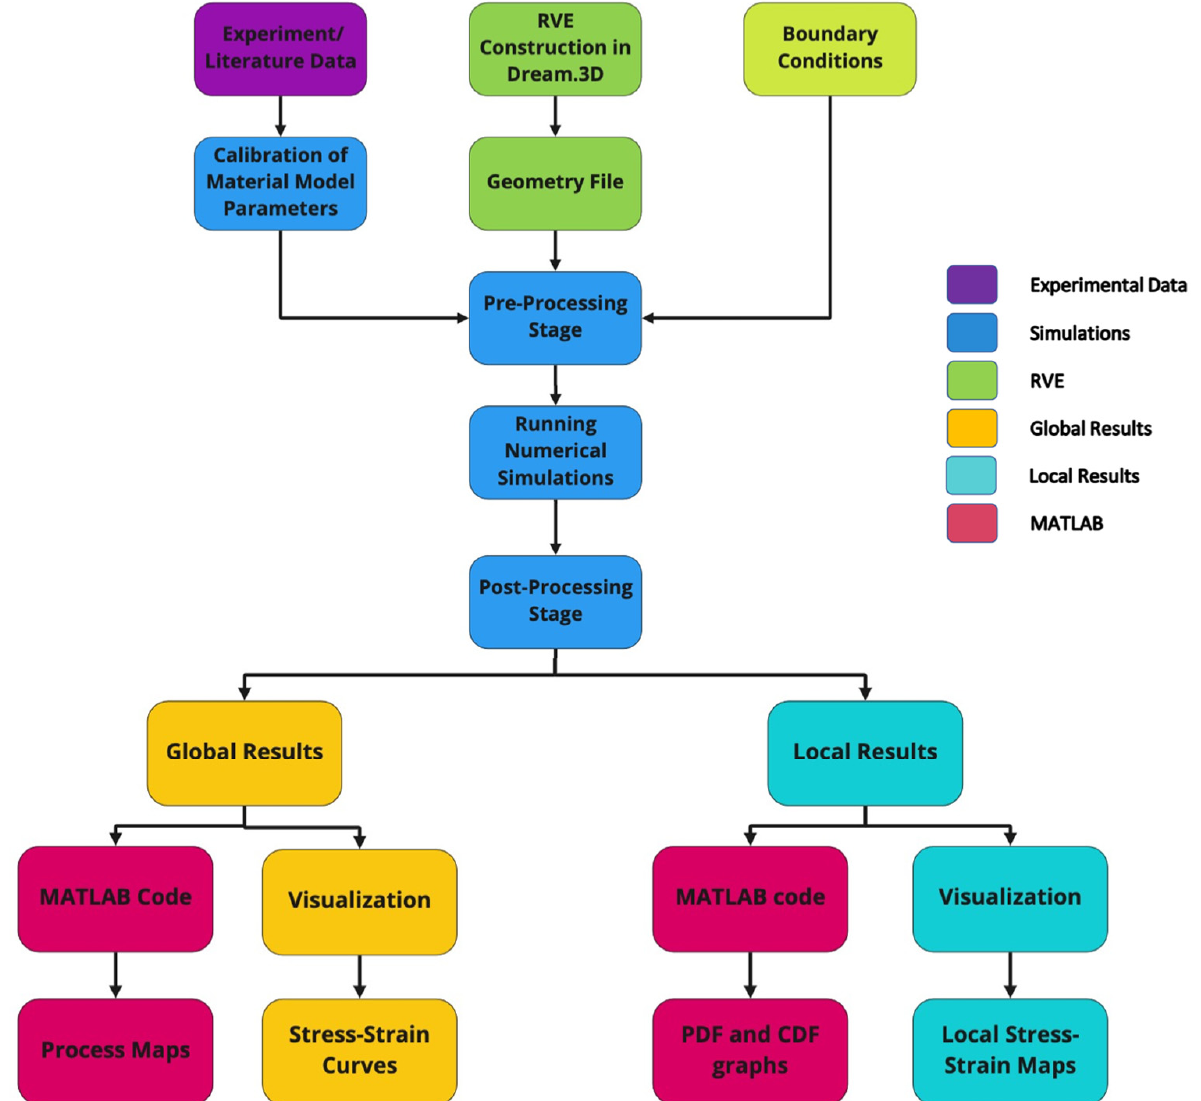
Figure 1. The flow chart shows the methodology adopted and the data flow in this study.